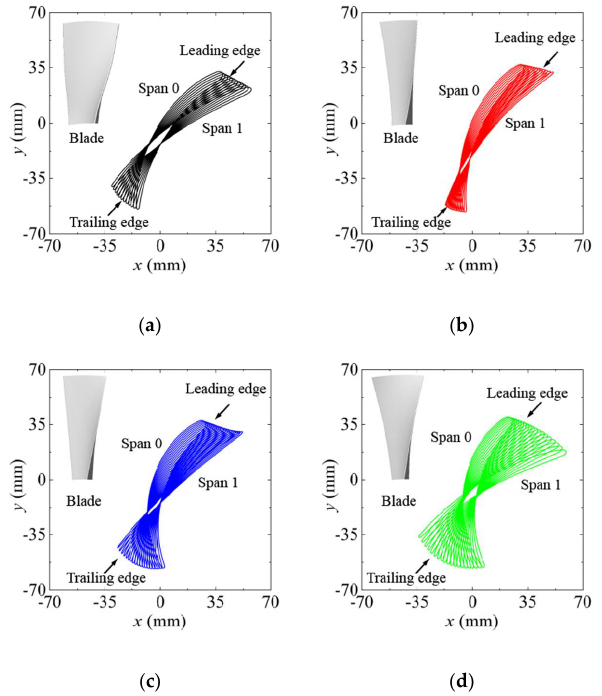
Figure 14. Comparison of blade profile and 3D modeling: ( a ) ORI; ( b ) MES; ( c ) MOS; ( d ) MPS.